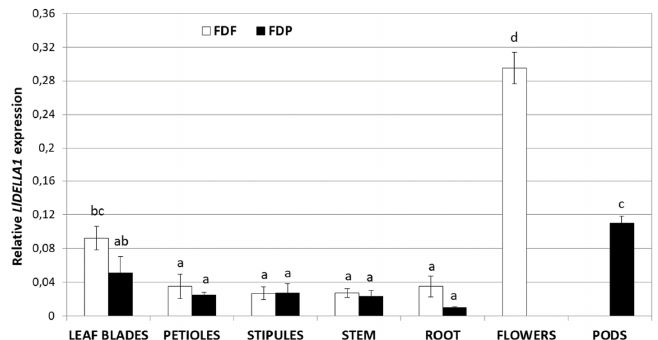
Figure 5. Expression profile of LlDELLA1 in vegetative (leaf blades, petioles, stipules, stem, root) and generative (flowers, pods) tissues of yellow lupine during generative development—fully